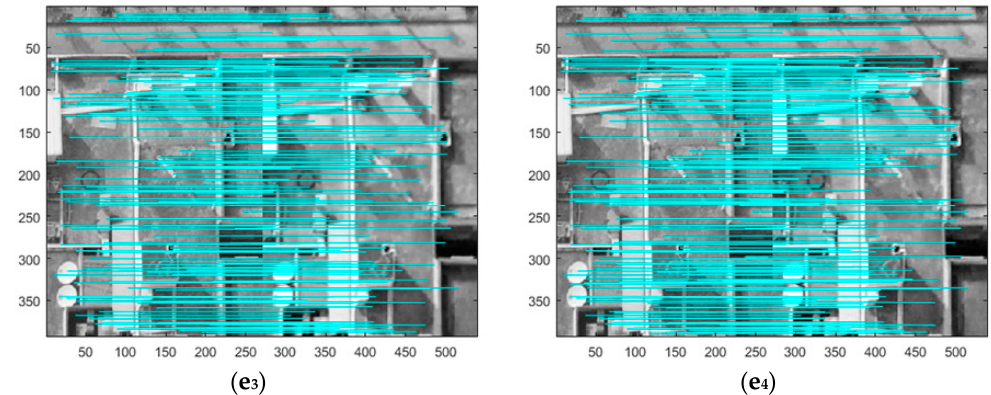
Figure 5. In each matching image, the left image is the original real clean UAV image, and the right image is the denoised UAV image (noise level 55). The 1st image ( b 1 , c 1 , e 1 ) presents matching results from SIFT and the denoised UAV images using method [8] and original real clean UAV images. The 2nd image ( b 2 , c 2 , e 2 ) presents matching results from SIFT and the denoised UAV images using method [5] and the original real clean UAV images. The 3rd image ( b 3 , c 3 , e 3 ) presents matching results from SIFT and the denoised UAV images created by method [17] and original real clean UAV images; and the 4th image ( b 4 , c 4 , e 4 ) presents matching results from SIFT and the denoised UAV images using proposed method and the original real clean UAV images.